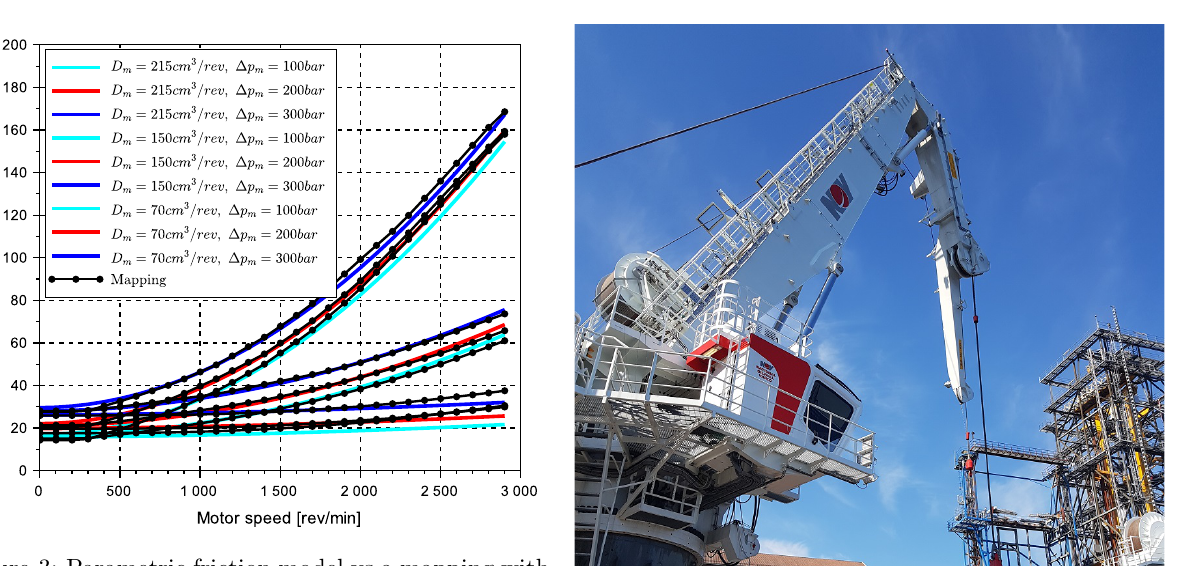
Figure 3: Parametric friction model vs a mapping with linear interpolation of the sub-suplier data for an A6VM (71 series) 215 cm 3 / rev from Bosch Rexroth.